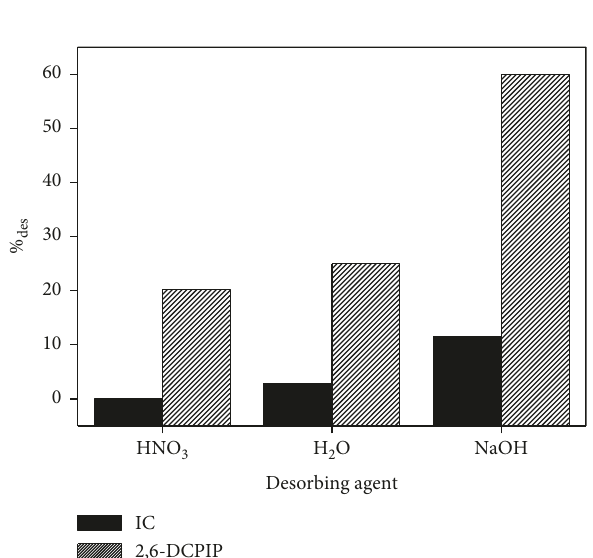
Figure 14: Effect of desorption solution on the recovery of IC and 2,6-DCPIP adsorbed. Experimental conditions: 4mg of IC or 2,6- DCPIP loaded biosorbents; G � 0–100 μ m; t � 40min for IC and t � 30 min for 2,6-DCPIP; v � 150rpm; V � 30 mL; at room